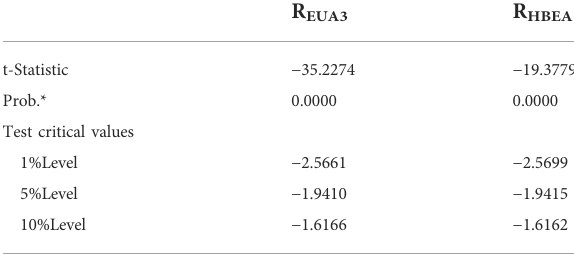
TABLE 3 ADF test of EUA futures and Hubei spot returns. The null hypothesisoftheADFtestisthepresenceofaunitroot,thatis,the series is nonstationary. R EUA3 R HBEA − 35.2274 − 19.3779 0.0000 0.0000